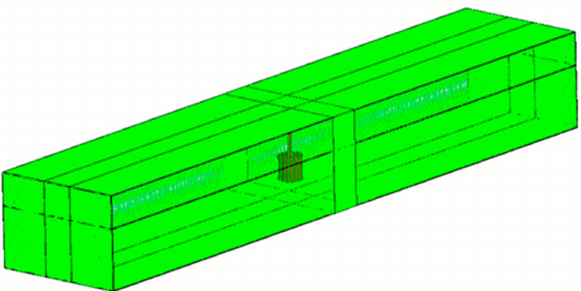
Figure 8. General view and the close-up of the rotor wall sector applied for the rotor simulation.